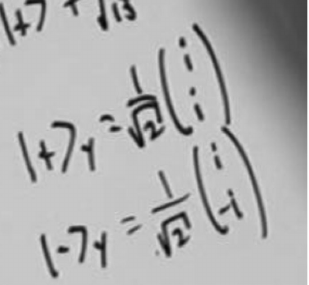
FIG. 4. Student C3 ’ s initial change of basis work in question